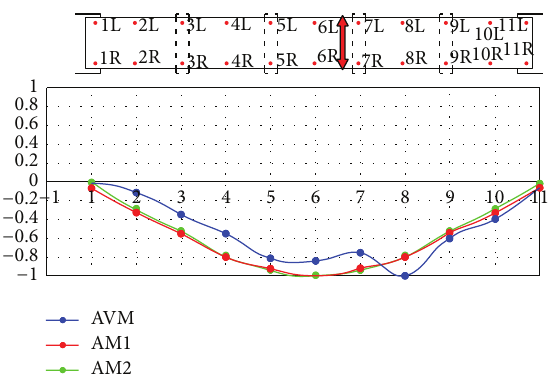
Figure 15: Experimentally and mathematically identified first transverse mode shapes.